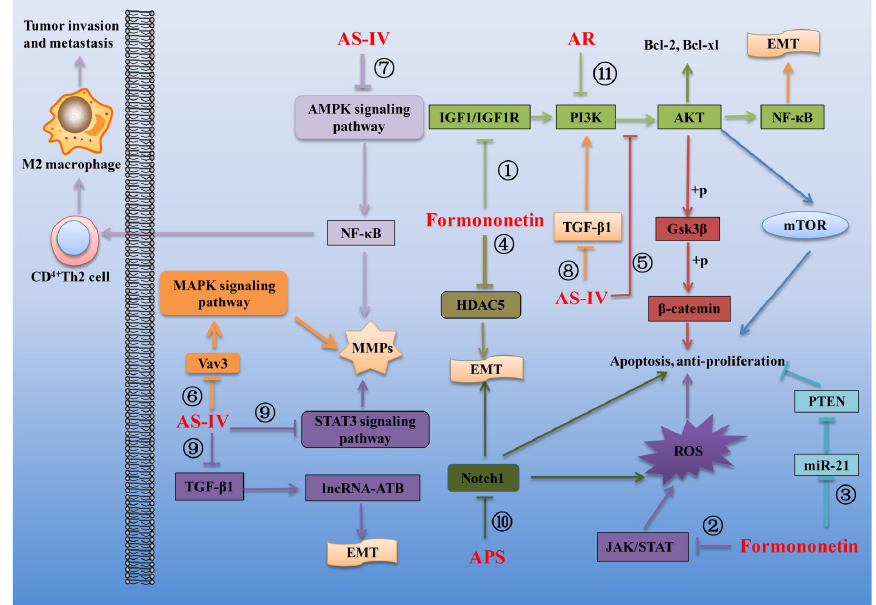
Figure 4. Several mechanisms linking AR and its main components to the treatment of cancer. Arrows and bar-headed lines represent signaling activation and inhibition, respectively. The different signaling pathways regulated by AR and its components are numbered ① to ⑪ .